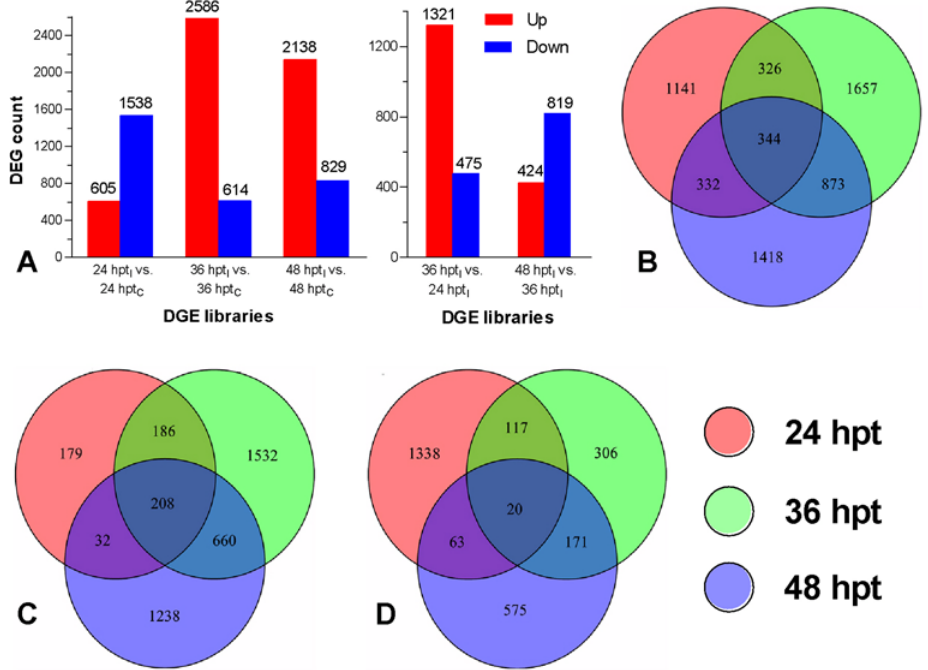
Fig 3. Identification of P . xylostella DEGs at 24, 36 and 48 h post treatment of infection (hpt I ) and control (hpt C ). ( A ) Counts of DEGs in the DGE libraries of 24 hpt I /24 hpt C , 36 hpt I /36 hpt C and 48 hpt I /48 hpt C (left) or of 36/24 hpt I and 48/36 hpt I (right). ( B – D ) Venn diagrams for the total counts of host genes differentially expressed and those upregulated and downregulated at 24, 36 and 48 hpt I respectively. Note the counts of those co-upregulated (C) or co-downregulated (D) at the two time points of 36/24 and 48/36 hpt I and at the three time